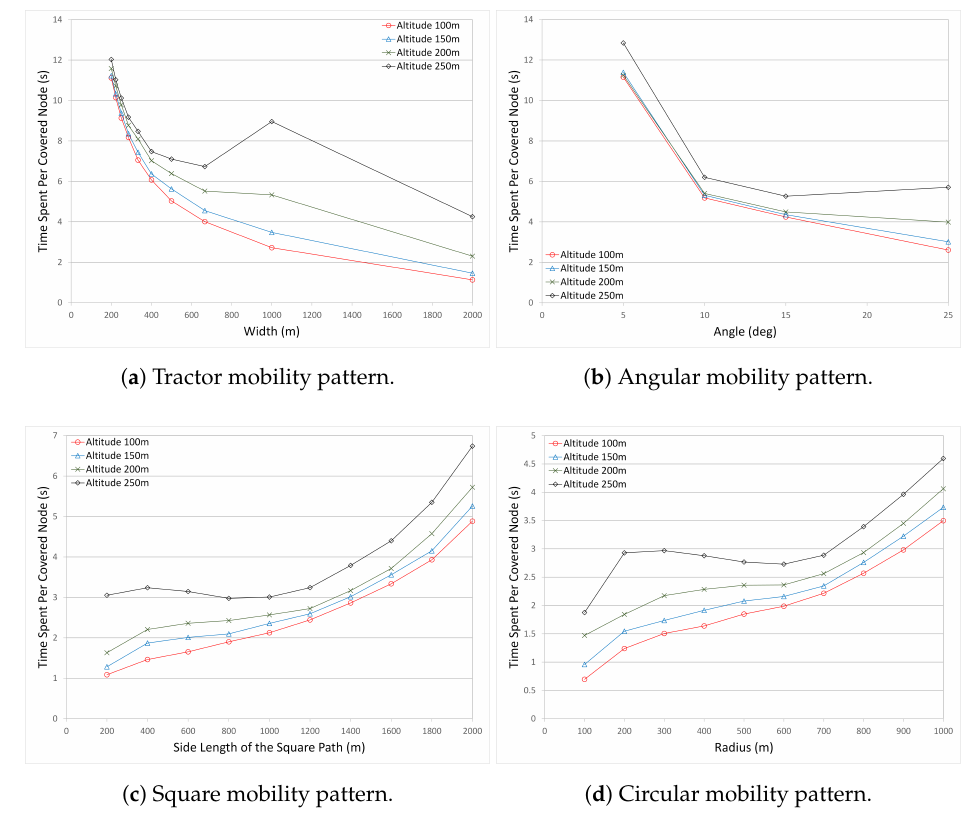
Figure 5. Comparison of the Time Spent Per Covered Node for all mobility